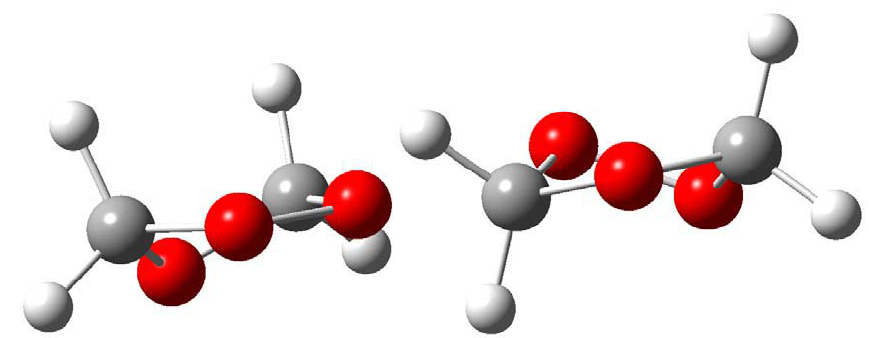
Fig. 2 Conformations of five membered ring of ethene secondary ozonide: a) C-O half- chair conformation; b) O-O half-chair